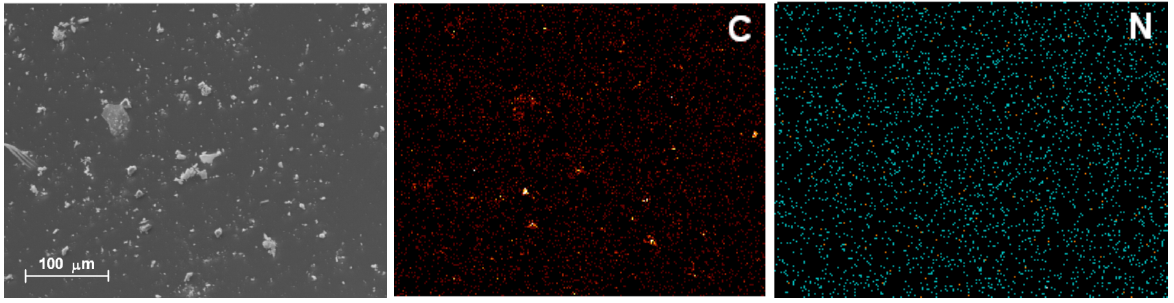
Figure 6. SEM image and carbon ( C ) and nitrogen ( N ) EDS mapping of the xerogel with the H T( p- COOH)PP species bonded using NAEPTES as a bridges and inside pores of 2 silica modified with dodecyl